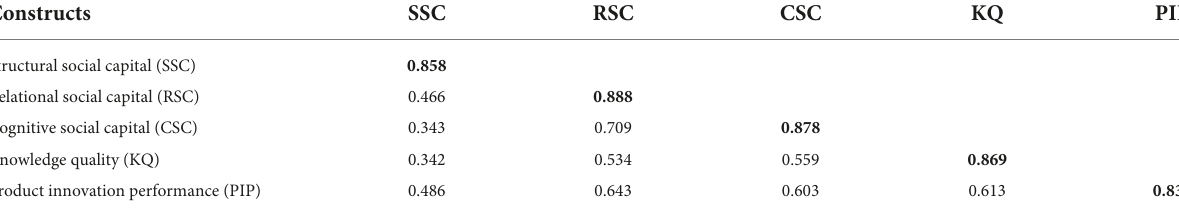
BoldvaluesshowthesquarerootofAVEforthecorrespondingconstruct.